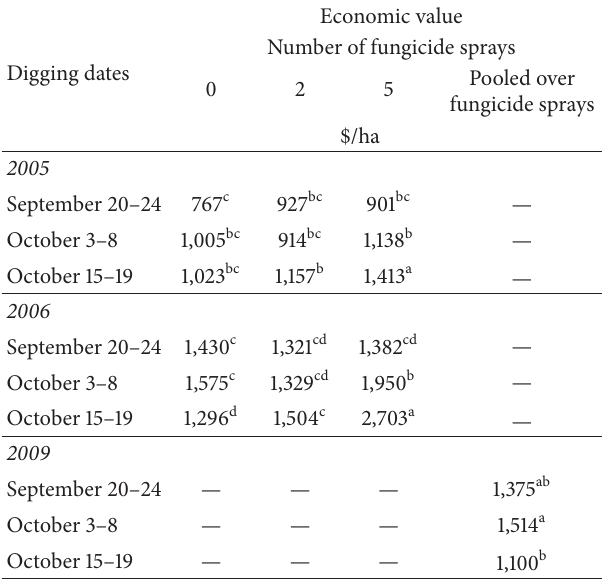
Table10:Economicvalueasinfluencedbytheinteractionofdigging date and fungicide regime and the main effect of digging date ∗